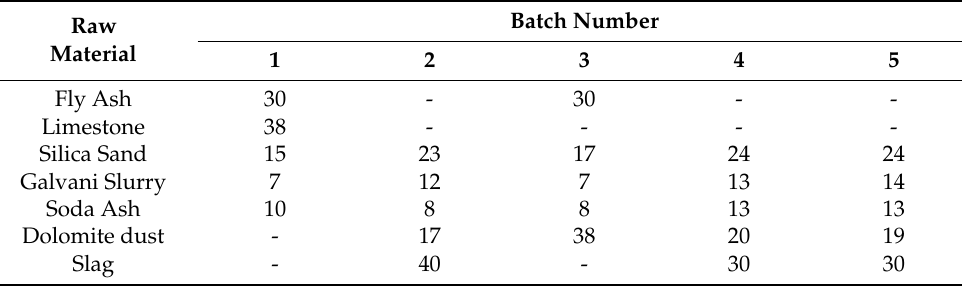
Table 2. Raw material mixtures used to formulate glass